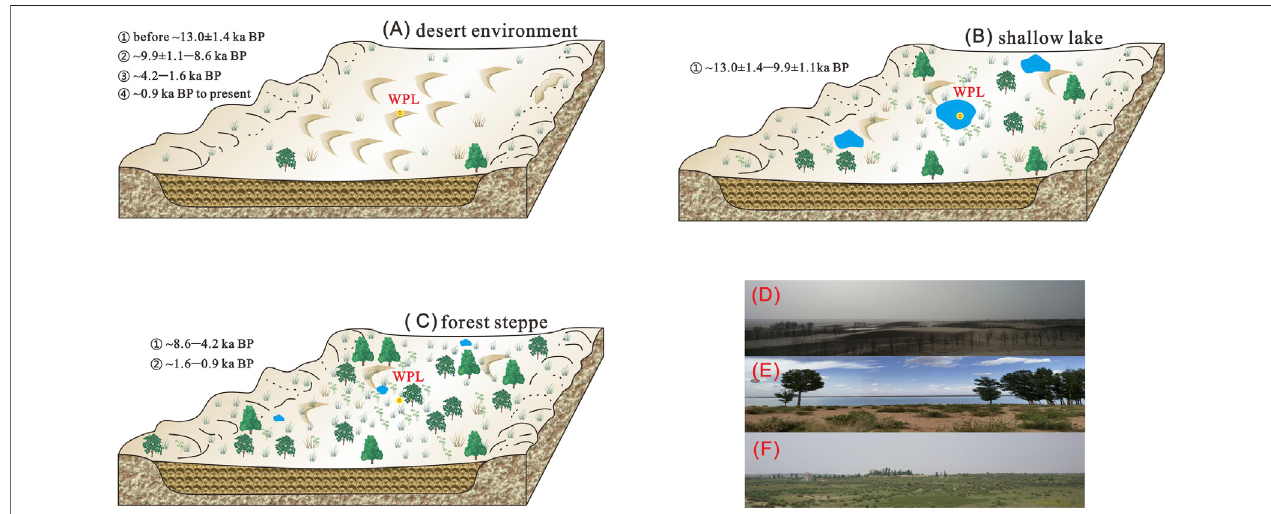
FIGURE 4 | The sketch map of regional sedimentary conditions. (A) Desert environment dominated by active dunes. (B) Shallow lake environment. (C) Forest steppeenvironmentwithluxuriantvegetation.Thereinto,thedifferencesbetweentheperiods8.6 kaBPto4.2 kaBPandfrom1.6 kaBPto0.9 kaBPwerein fl uencedby the amount of vegetation in the vicinity; (D) landscape photo of a desert environment, which was taken at the hinderland of the modern Mu Us Desert; (E) landscape photo of a shallow lake, which was taken at Manai Lake in the modern Mu Us Desert; (F) landscape photo of a forest steppe environment, which was taken at Tongwan City in the southern margin of the modern Mu Us